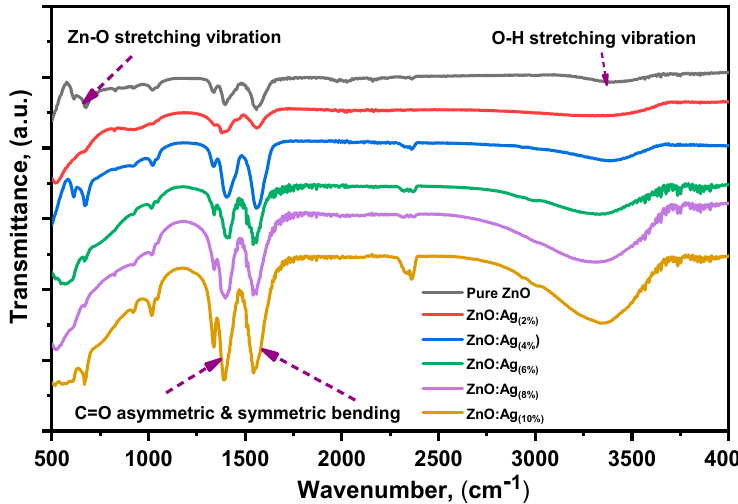
Figure 8. FTIR spectrum of pure and Ag-doped ZnO submicron